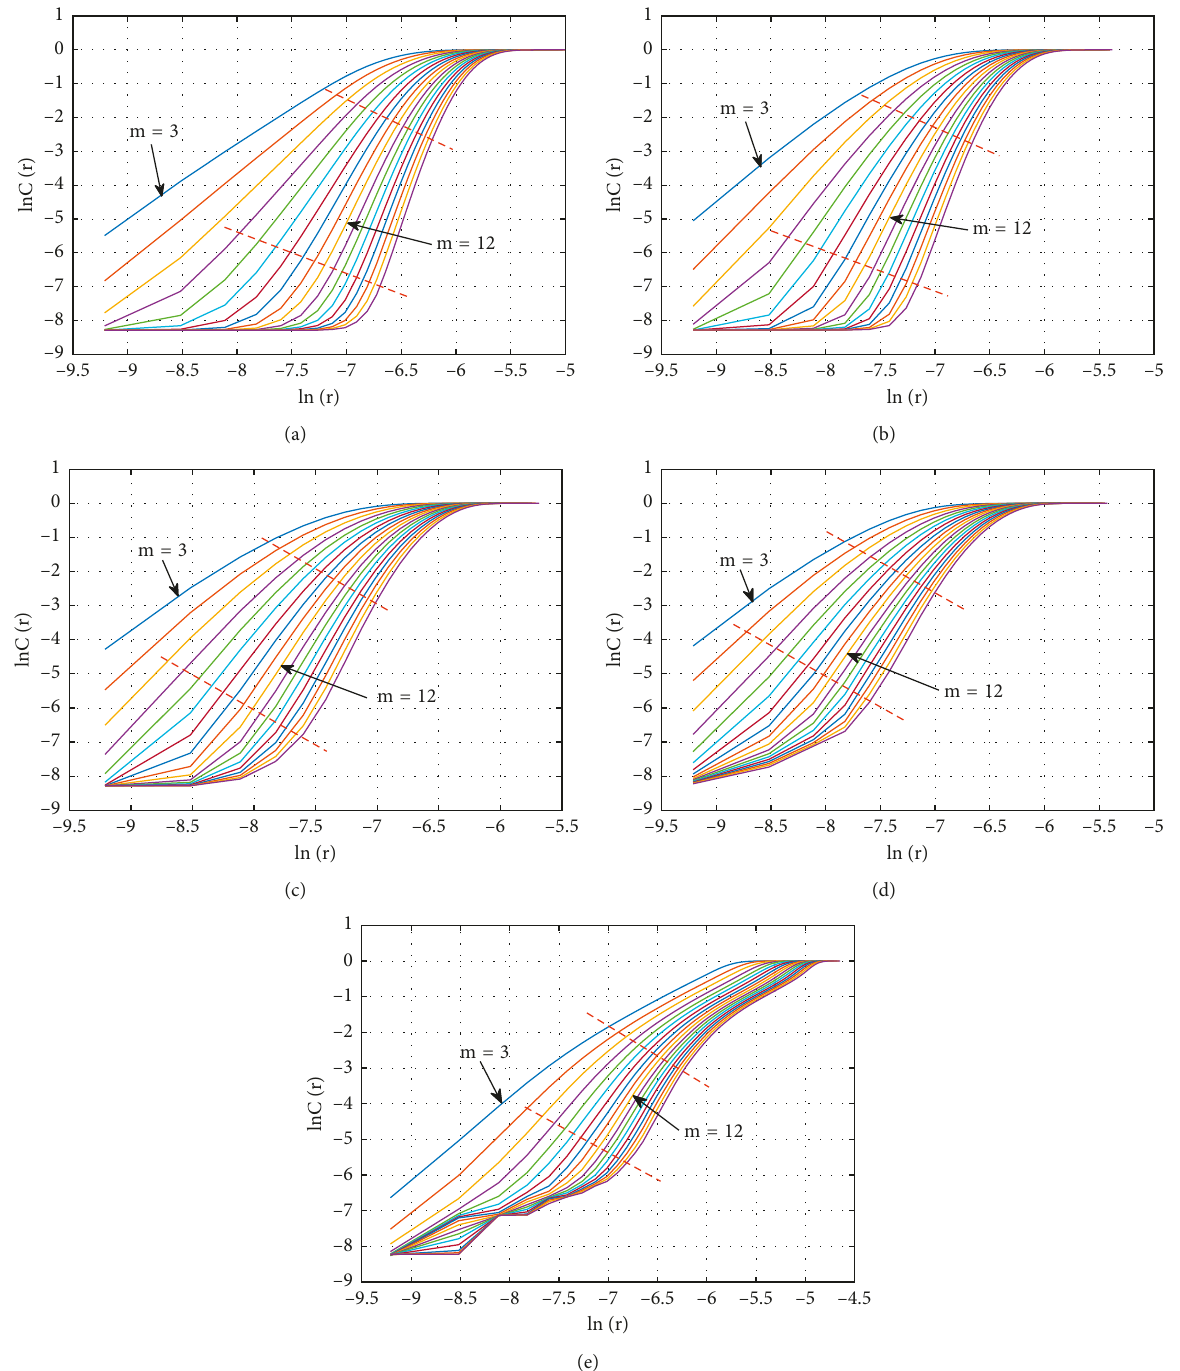
Figure 4: The correlation integral map of 5 IMFs under normal condition. (a) IMF1. (b) IMF2. (c) IMF3. (d) IMF4. (e)